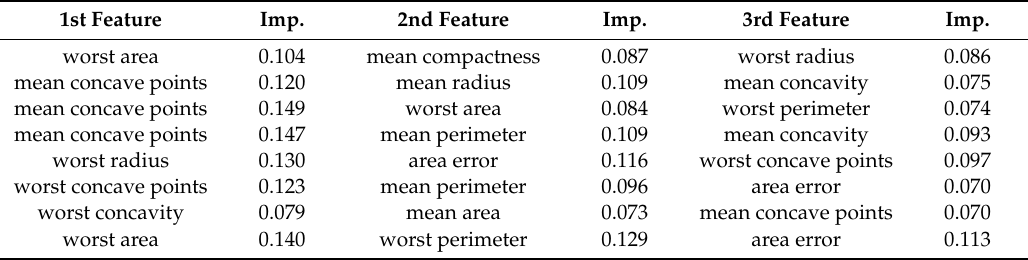
Table 3. The three most important features and their importance—UCI-BCW dataset, 20 runs. Each row contains the three most important features from a single run with their respective importance values for the built-in